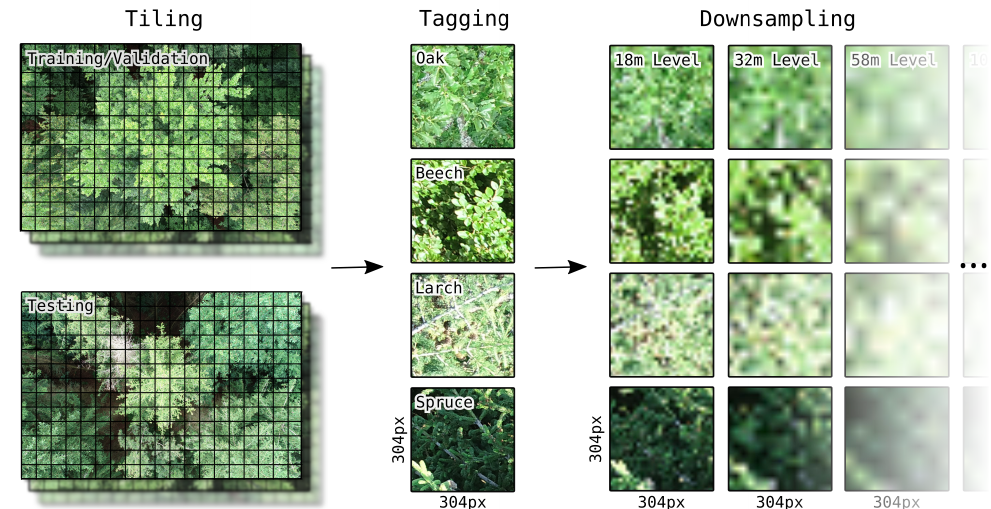
Figure 3. Image data preparation steps: Schematic depiction of the tiling, tagging and downsampling procedure of the image